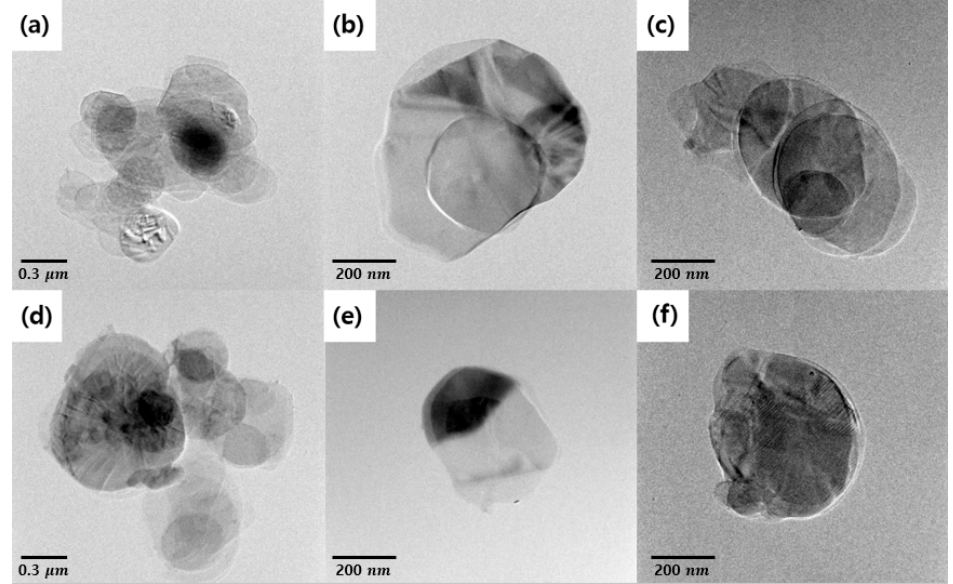
Figure 5. High-resolution transmission electron microscopy (HR-TEM) image of BNNs–A particles ( a – b ), BNNs–B particles ( c – d ) and BNNs–C particles ( e – f ).